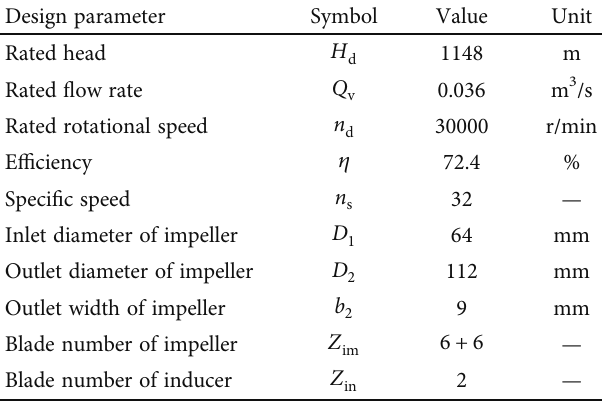
Table 1: Main design parameters of the LOX turbopump. Design